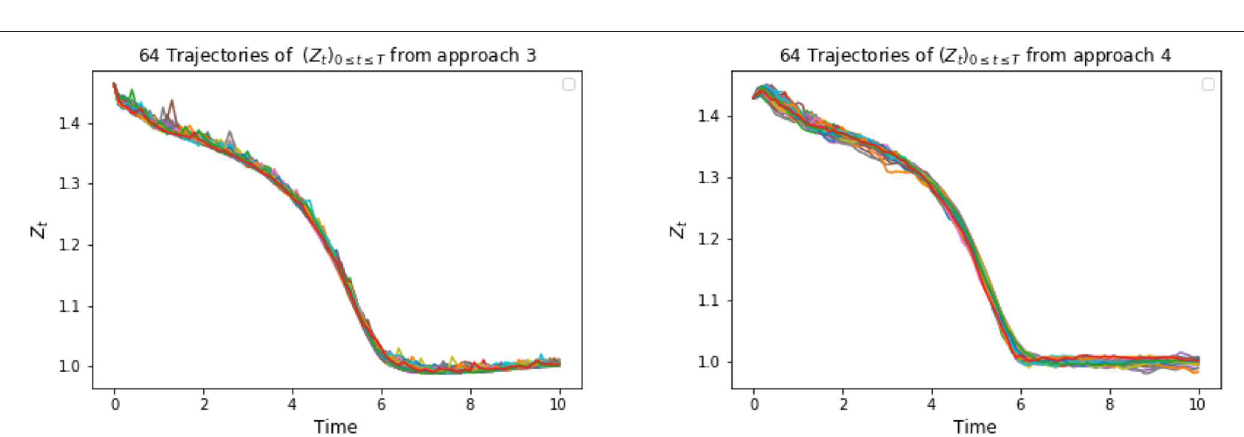
FIGURE 7 | 64 trajectories of ( Z t